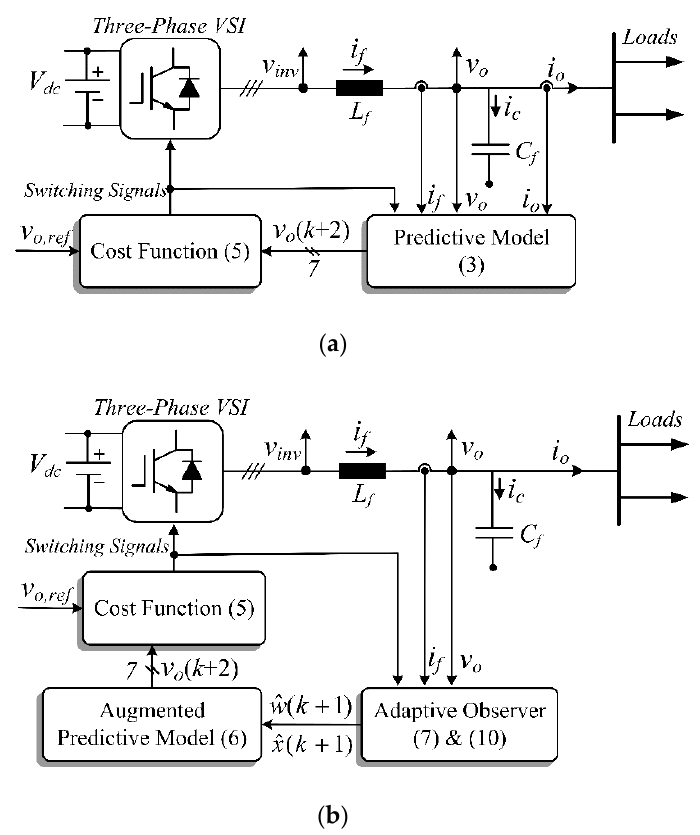
Figure 1. Single-phase diagram of three-phase LC-filtered voltage source inverter (VSI) under ( a ) conventional model predictive control (MPC), ( b ) proposed adaptive MPC.